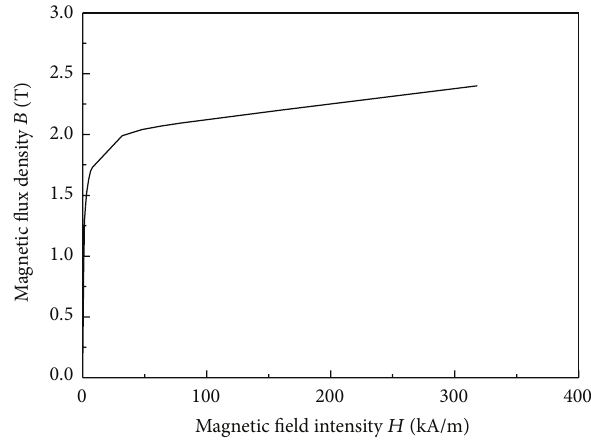
Figure 6: 𝐵 - 𝐻 curve of 10# steel material.